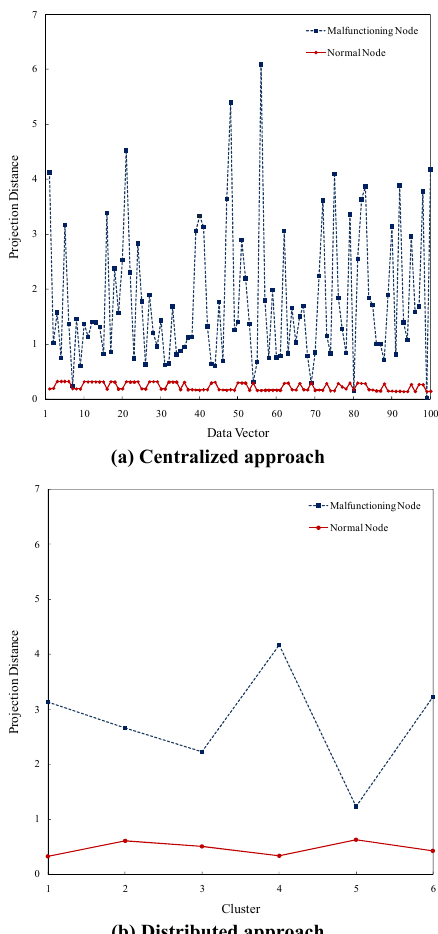
Figure 8. Projection distance from the global first principal component during a time window.